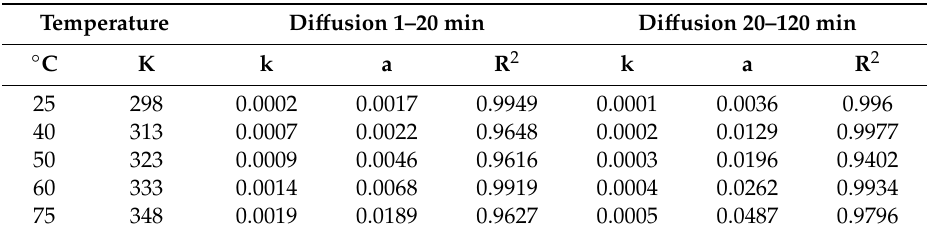
Table 2. Correlation coe ffi cients of di ff usion-controlled kinetics models at di ff erent temperatures for total